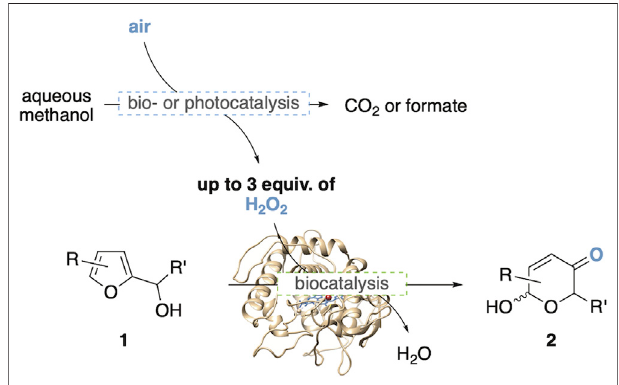
FIGURE 1 | Enzymatic or photocatalytic O 2 -activation as tools for methanol-driven Achmatowicz-type ring expansions.